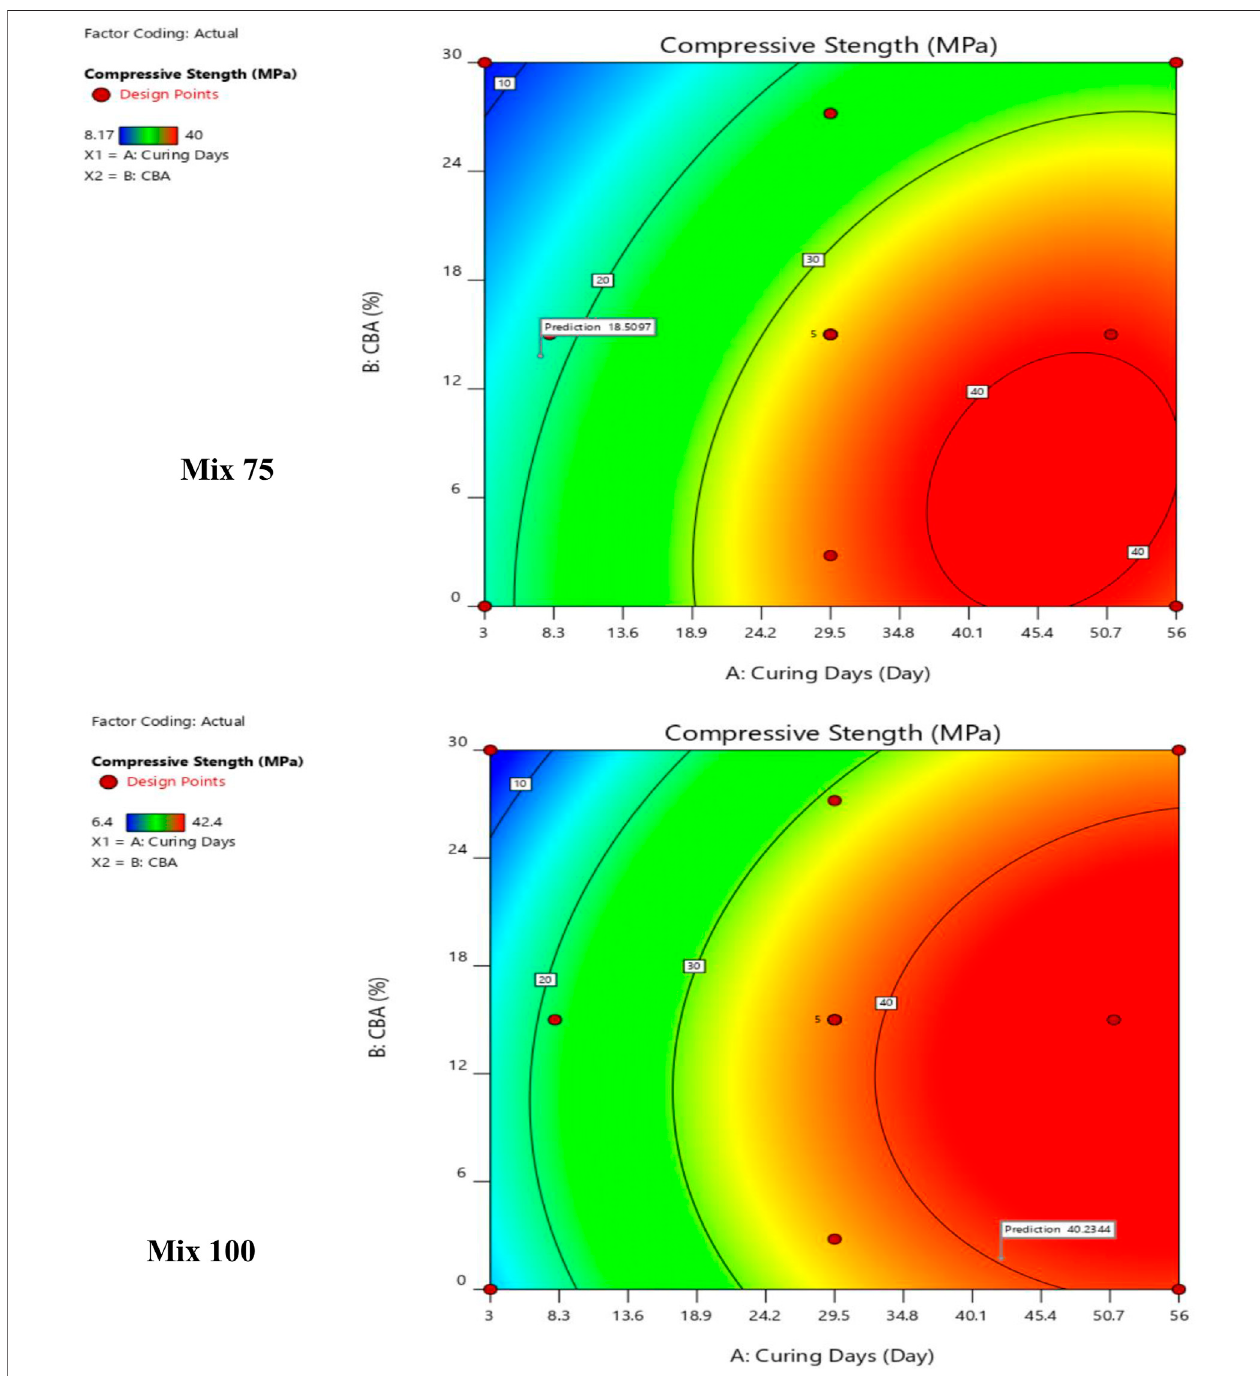
FIGURE 11 | Contour plots for CBA (%), curing days (day), and compressive strength (MPa).